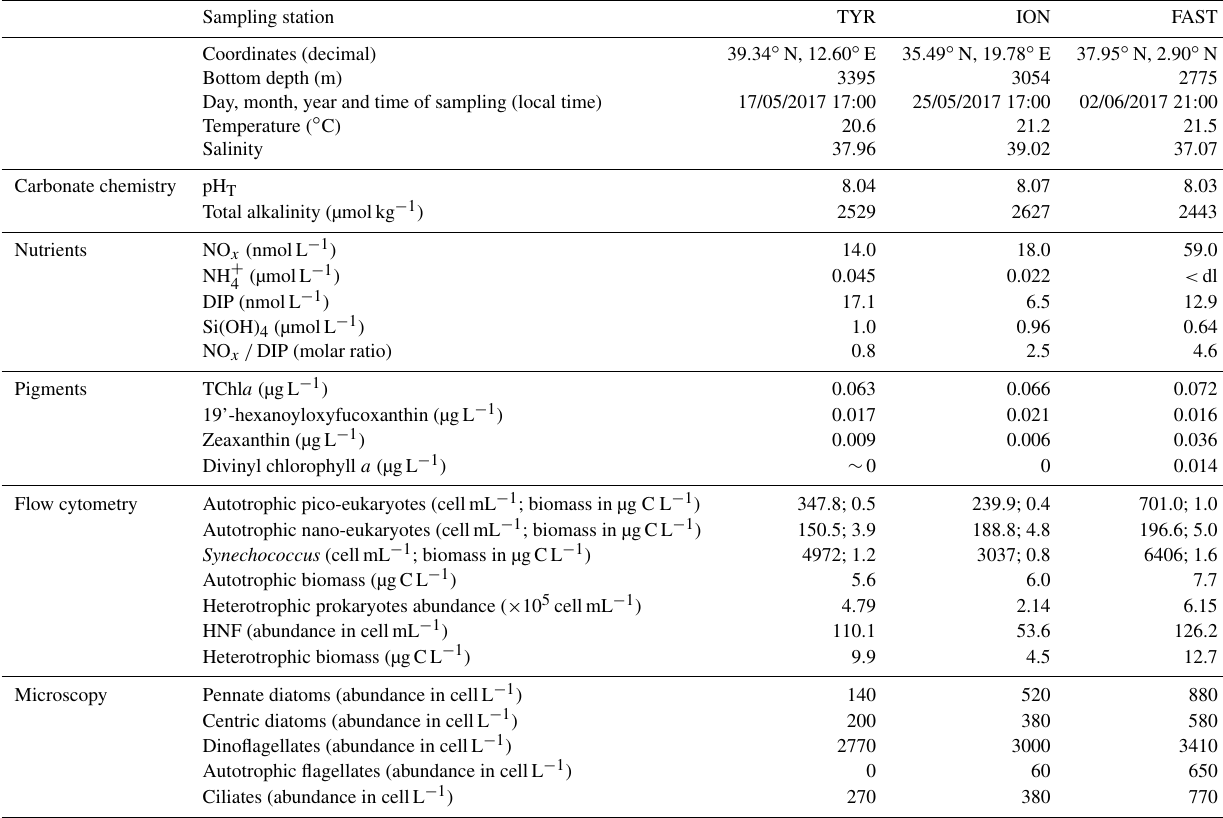
Table 2. Initial conditions (sampling time t-12h) at stations TYR, ION and FAST measured while filling the tanks. pH T : pH on the total scale, NO x : nitrate + nitrite, NH 4 : ammonium, DIP: dissolved inorganic phosphorus, Si(OH) 4 : silicate, TChl a : total chlorophyll a , HNF: heterotrophic nanoflagellates. The three most important pigments in terms of concentration are also presented (19’-hexanoyloxyfucoxanthin, zeaxanthin and divinyl chlorophyll a ). Biomasses of the different groups analysed through flow cytometry were estimated based on con- version equations and/or factors found in the literature (see Sect. 2.3). Autotrophic and heterotrophic biomass based on flow cytometry (fraction < 20µm). Values below detection limits are indicated as <